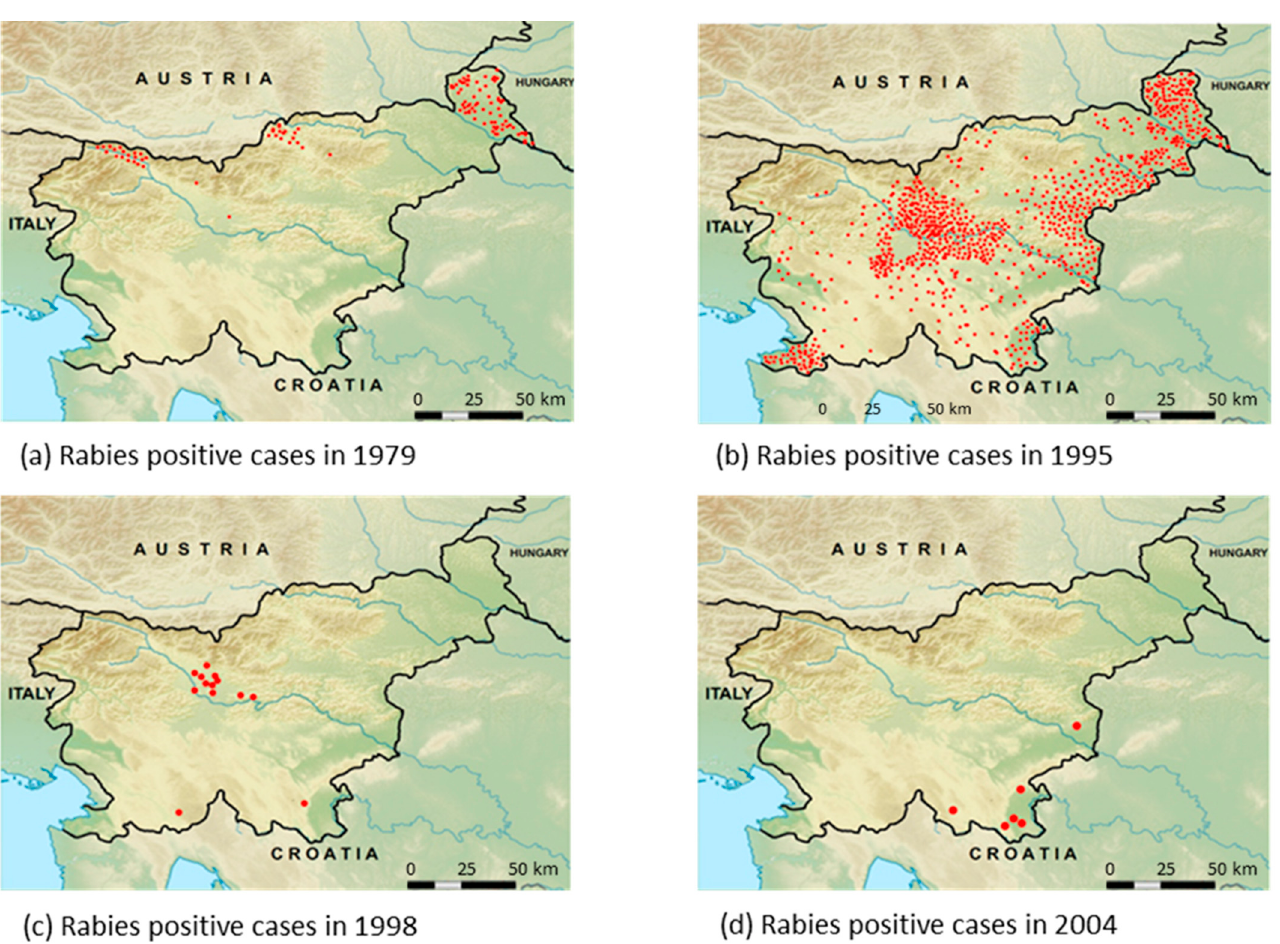
Figure 3. The detected rabies-positive cases by FAT in Slovenia in 1979 ( a ), 1995 ( b ), 1998 ( c ), and 2004 ( d ).